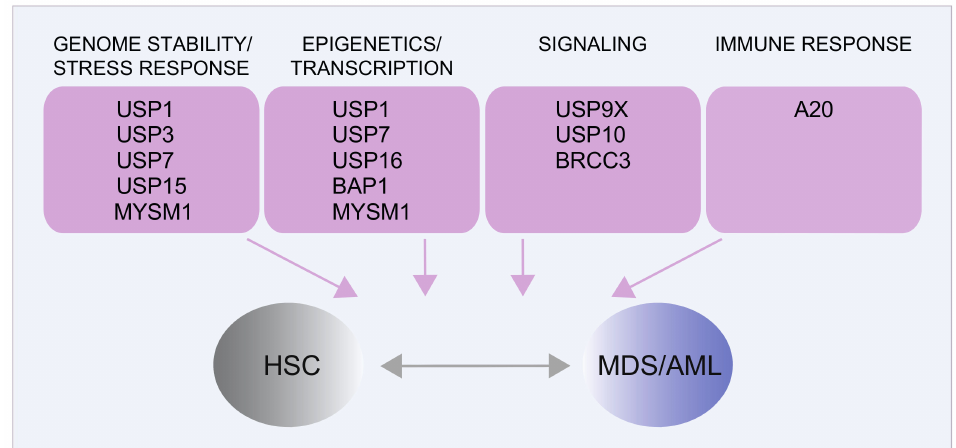
Figure 4. DUBs linked to normal HSC function and their implications in MDS/AML. The main DUBs involved in normal HSC or in MDS/AML biology and the main related cellular processes are shown. Additional functional roles of the same DUBs have been described in other cellular contexts and diseases